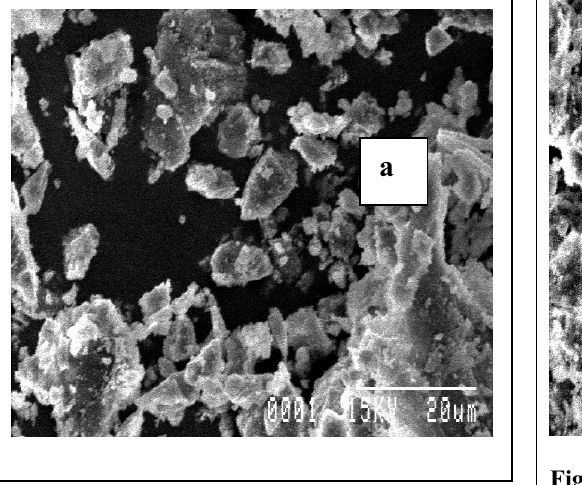
Figure 3(b). Scanning electron microscopy of egg shell after passing fluoride solution. b  Adhesive